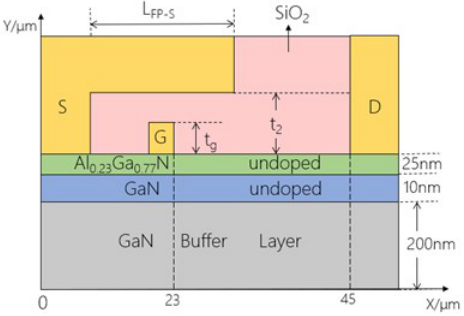
Figure 4. Device structure with FP-S analyzed in this study.